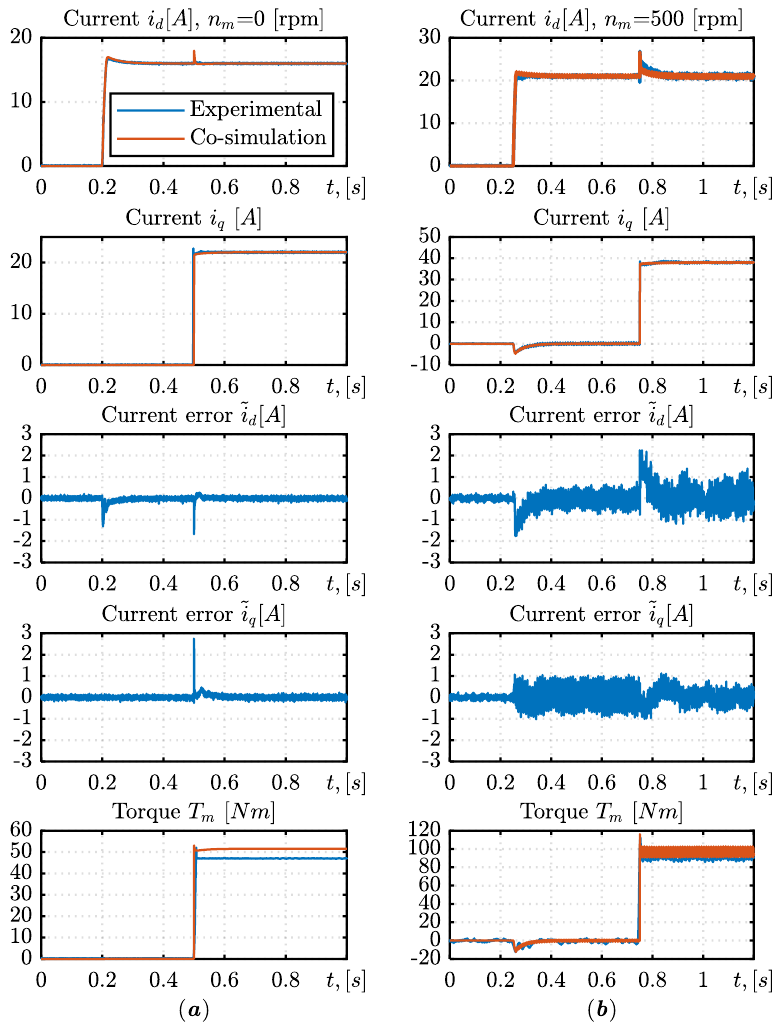
Figure 14. Responses of i d and i q for the step change for 0 rpm ( left ) and 500 rpm ( right ). As can be seen, the co-simulation and experimental results show good agreement. The cross-coupling and transient of the two current components can be identified in the measurement plots as well as in the profiles of the co-simulation results. Based on the measured torque, it can be said that the co-simulation slightly overestimates the torque value by